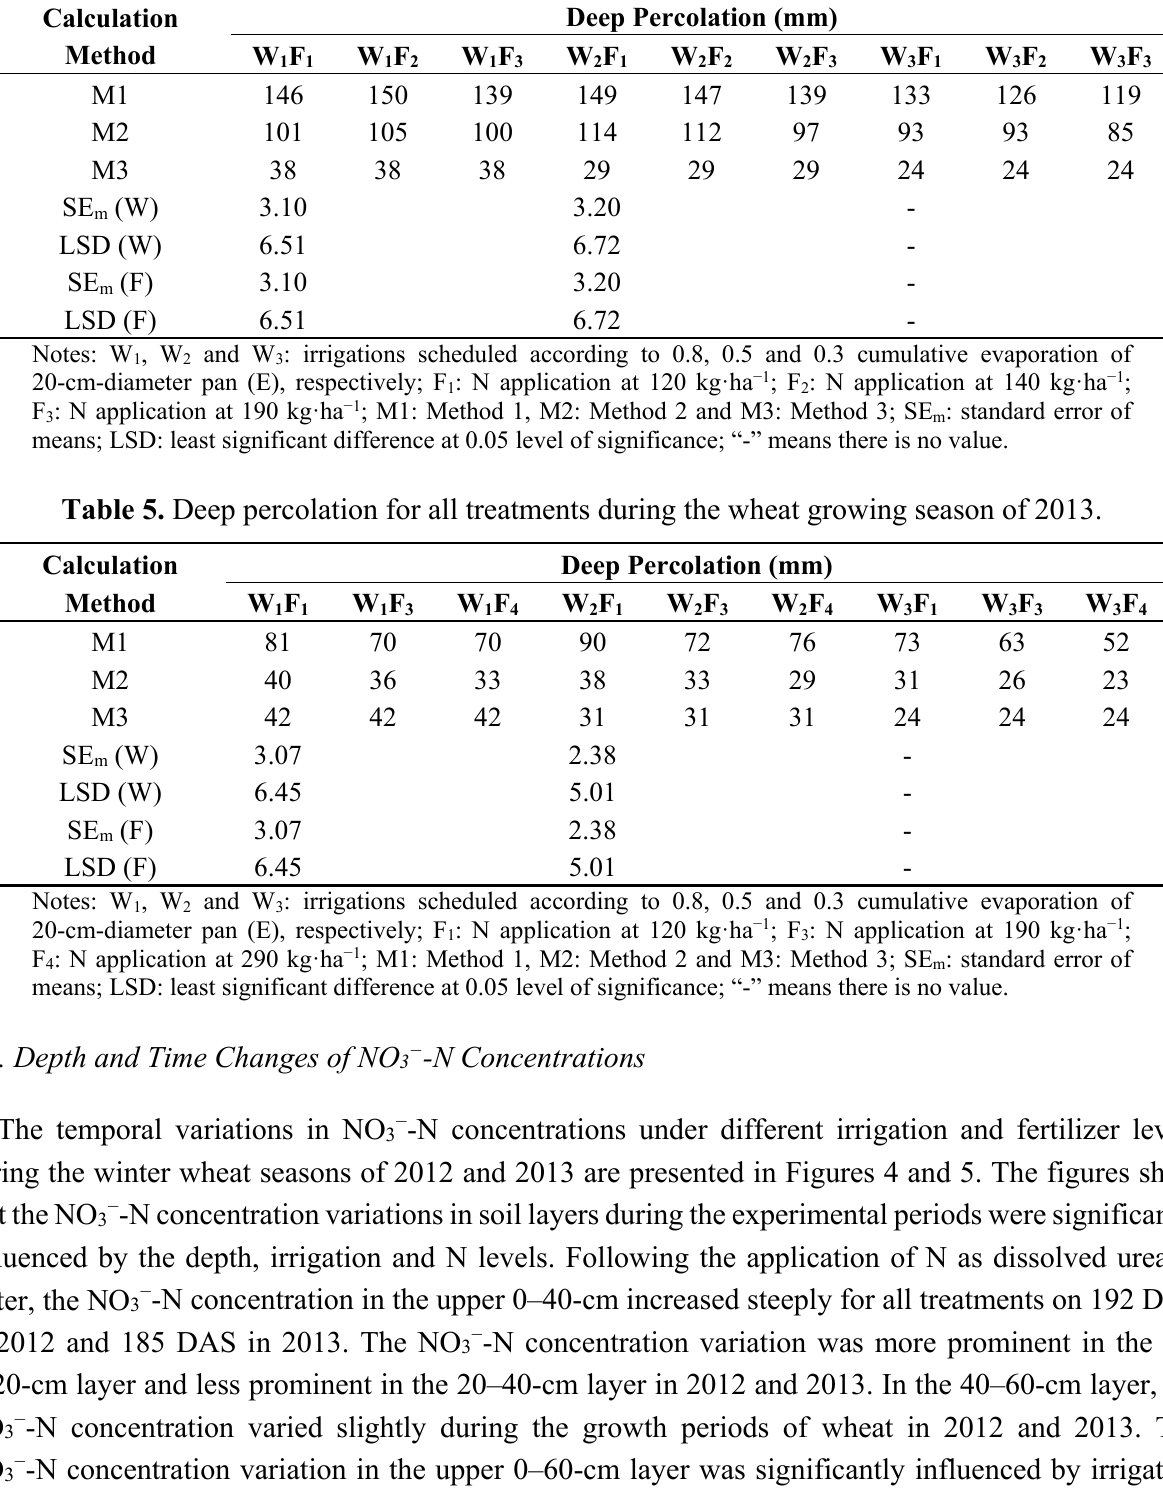
Table 4. Deep percolation for all treatments during the wheat growing season of 2012. Calculation